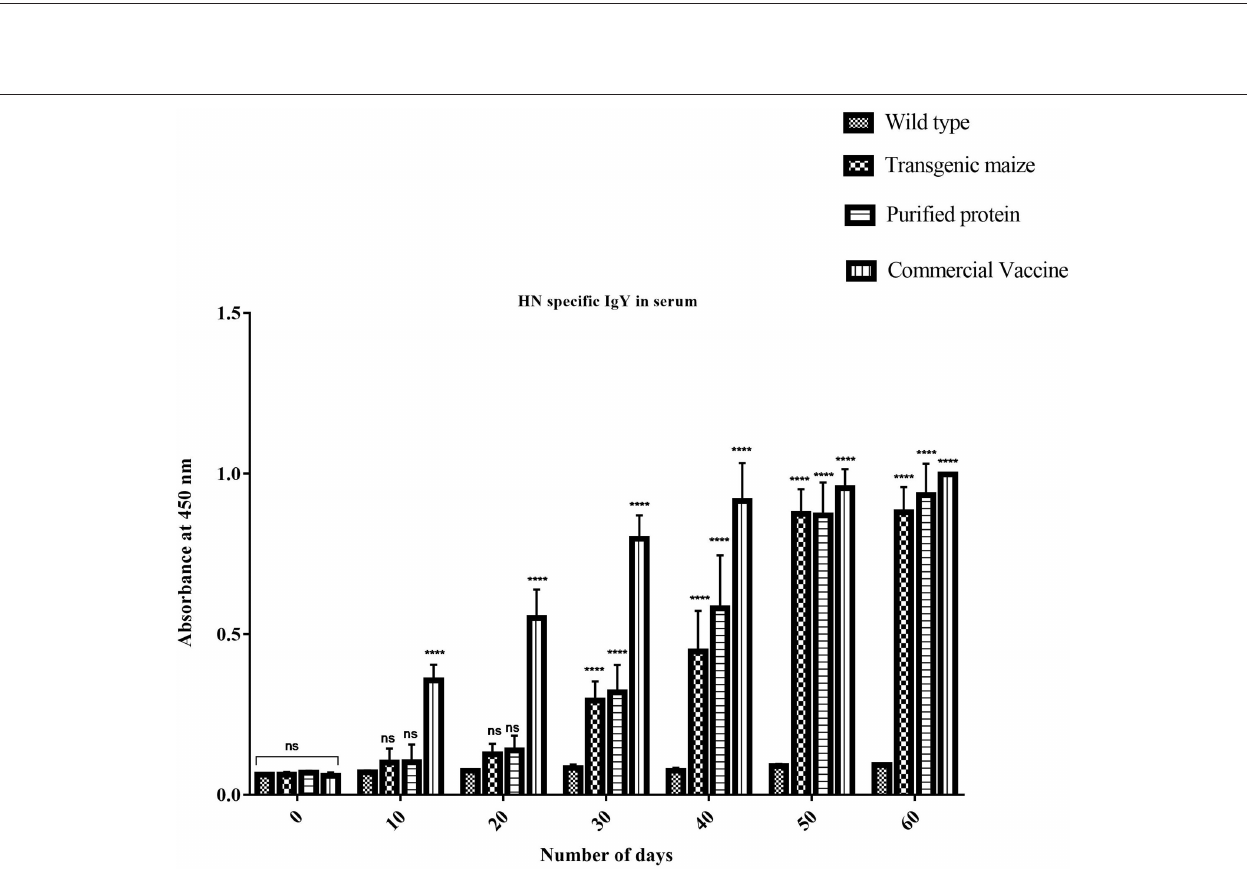
Frontiers in Veterinary Science |